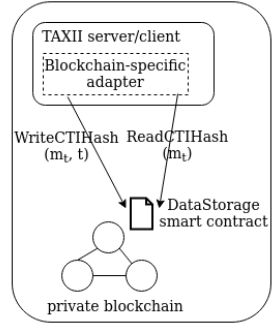
Figure 5. The high-level view of a blockchain-specific